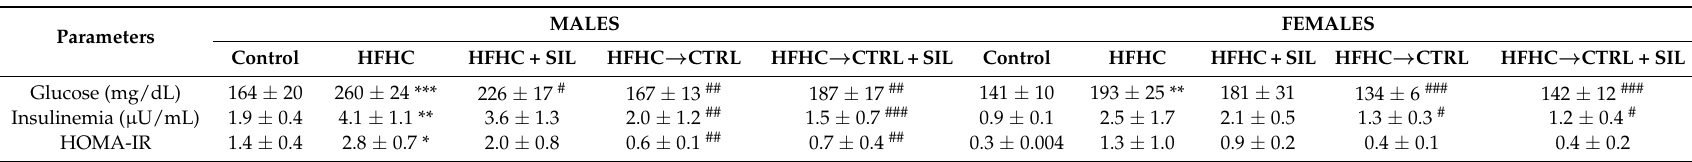
Table 3. Changes in glucose